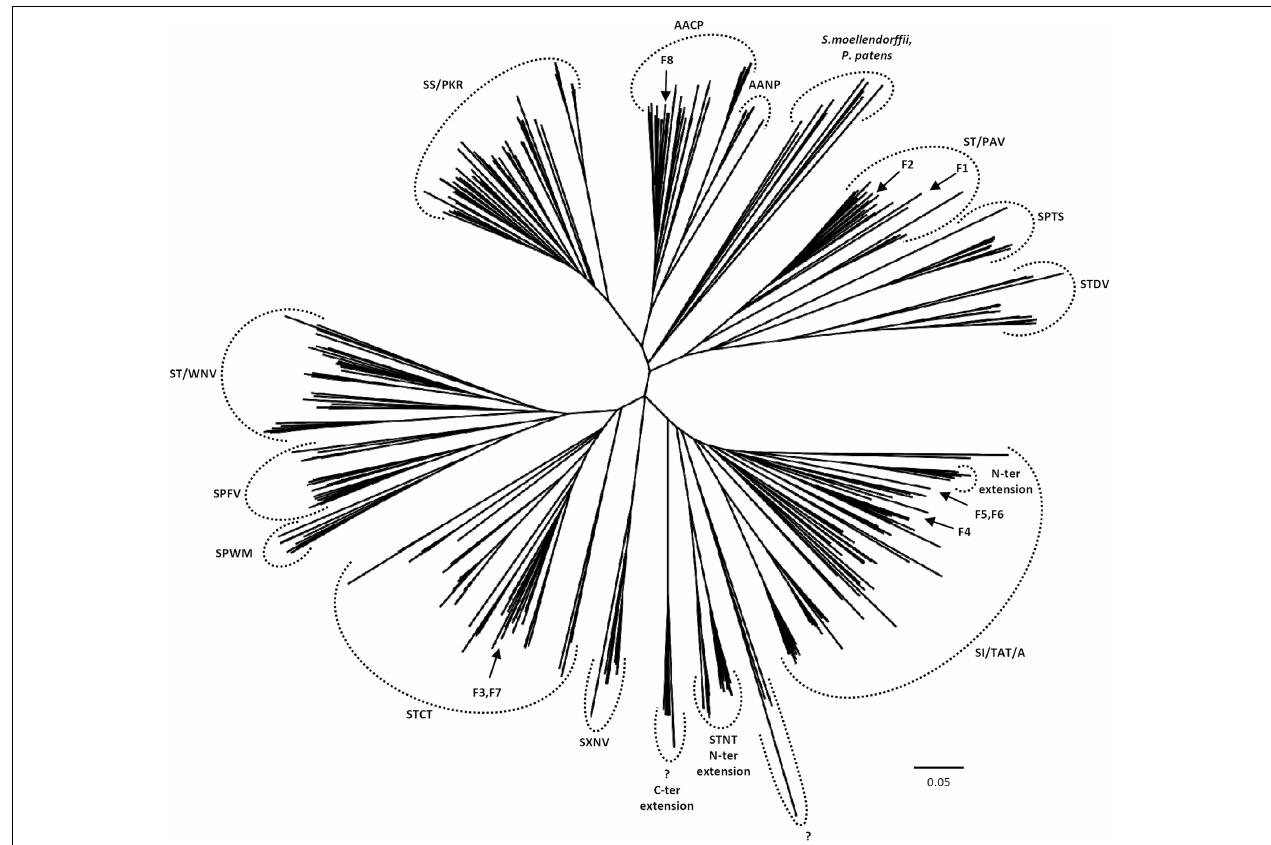
FIGURE 2 | Unrooted phylogenetic tree of GSTFs from terrestrial plants. The alignment was performed with PROMALS3D using 1BYE, 1AXD, 1AW9, 1GNW, and 1BX9 protein structure models as templates. The alignment was subsequently manually adjusted by using Seaview software. Phylogenetic tree was built with BioNJ and edited with Figtree software (http://tree . bio . ed . ac . uk/software/figtree/). Five hundred bootstrap replicates were performed in